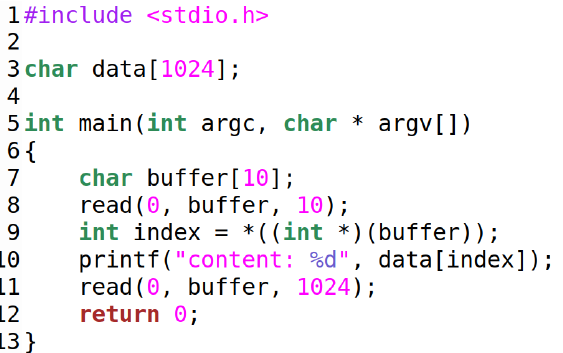
Figure 6. A Demostration Example on Implicit